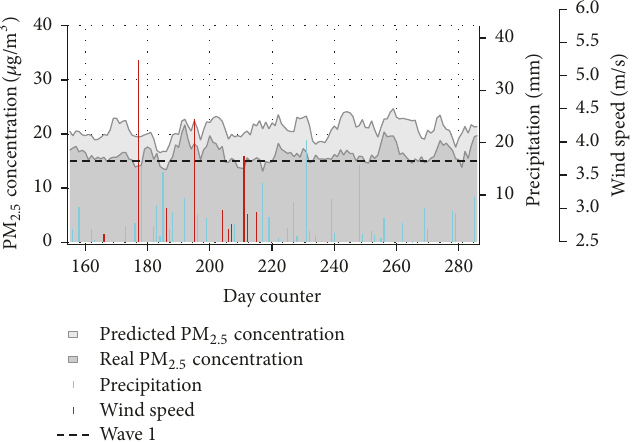
Figure 9: Neural Network’s regressive prediction of Cotocollao PM 2.5 concentration (light grey) compared to the real data (dark grey) during the wet season plotted against daily rain accumulation and wind speed thresholds, > 1mm and > 2.5 m/s, respectively (see Table 6, thresholds obtained from 3-class classification). The dashed black line represents the national standards for PM 2.5 annual concentrations.